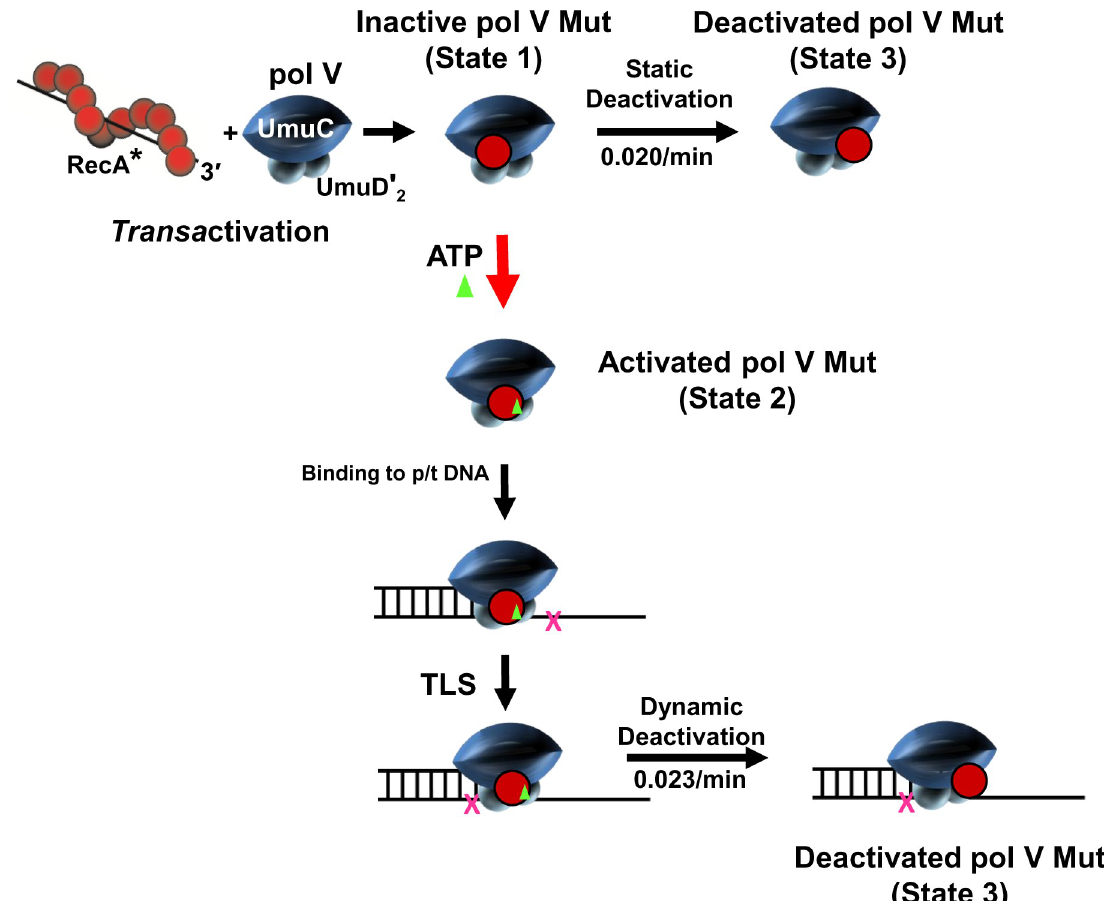
Fig 10. Conformational regulation of pol V Mut. The first step in pol V Mut regulatory pathway requires transfer of a molecule of RecA from the 3’-tip of a RecA � nucleoprotein filament to pol V (UmuD’ 2 C) to form pol V Mut (UmuD’ 2 C-RecA). Pol V Mut exists in 3 conformational states determined by the orientation of RecA on pol V. When first assembled pol V Mut (UmuD’ 2 C-RecA) is catalytically inactive (State 1) and cannot bind to p/t DNA. A subsequent addition of ATP (or ATP γ S) activates pol V Mut = UmuD’ 2 C-RecA-ATP (State 2) due to ATP induced reorientation of RecA relative to UmuC, termed “ATP induced RecA switch”. Once activated, pol V Mut can bind to p/t DNA and synthesize DNA, including TLS (X denotes a DNA template lesion). Pol V Mut can either statically deactivate in the absence of DNA synthesis (State 3) with a rate of about 0.02/min at 37˚C or deactivate dynamically (State 3) in the presence of DNA synthesis (0.023/min at 37˚C). Deactivated pol V Mut can be activated (i.e., reactivated) via transfer of a “new” molecule of RecA from the 3’-tip of a RecA � nucleoprotein filament, in which the new RecA replaces the old RecA [11], followed by binding of ATP/ATP γ S. Deactivated pol V Mut cannot be reactivated by binding to ATP or ATP γ S. Both deactivation processes occur more rapidly at at 37˚C compared to at 30˚C. Deactivation is inhibited in the presence of bound ATP and accelerated in the presence of bound p/t DNA – see text.